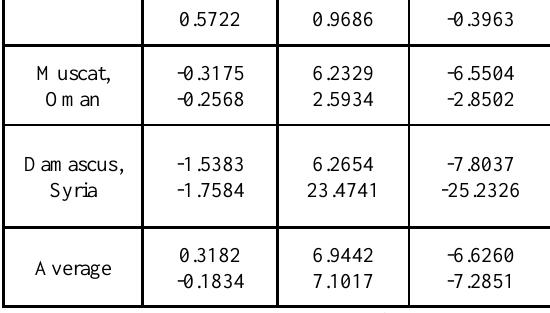
Table 4. Pitch/Roll Error Values for HPT-R